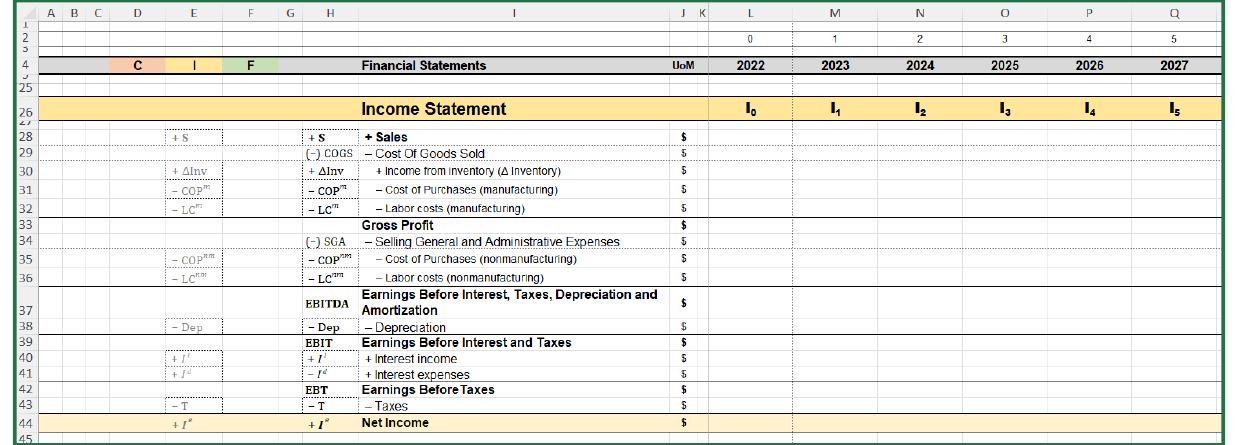
Figure 49. Structure of the income statements in the spreadsheet (“ConventionalFinStat” sheet).